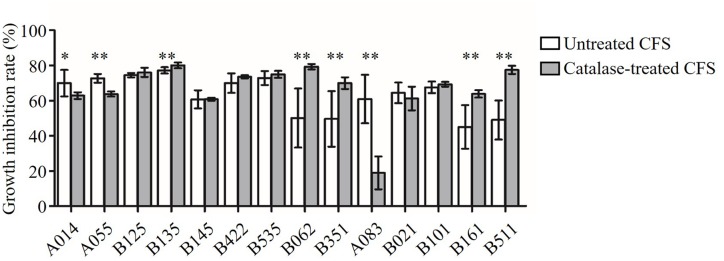
Inhibition of C. albicans growth by CFS and catalase-treated CFS. Growth inhibition rate (%) = (ODcontrol – ODCFS)/ODcontrol × 100. The statistical comparison between the catalase untreated and treated groups for each of the CFS was performed by Student’s t-test. ∗P < 0.05, ∗∗P < 0.01.